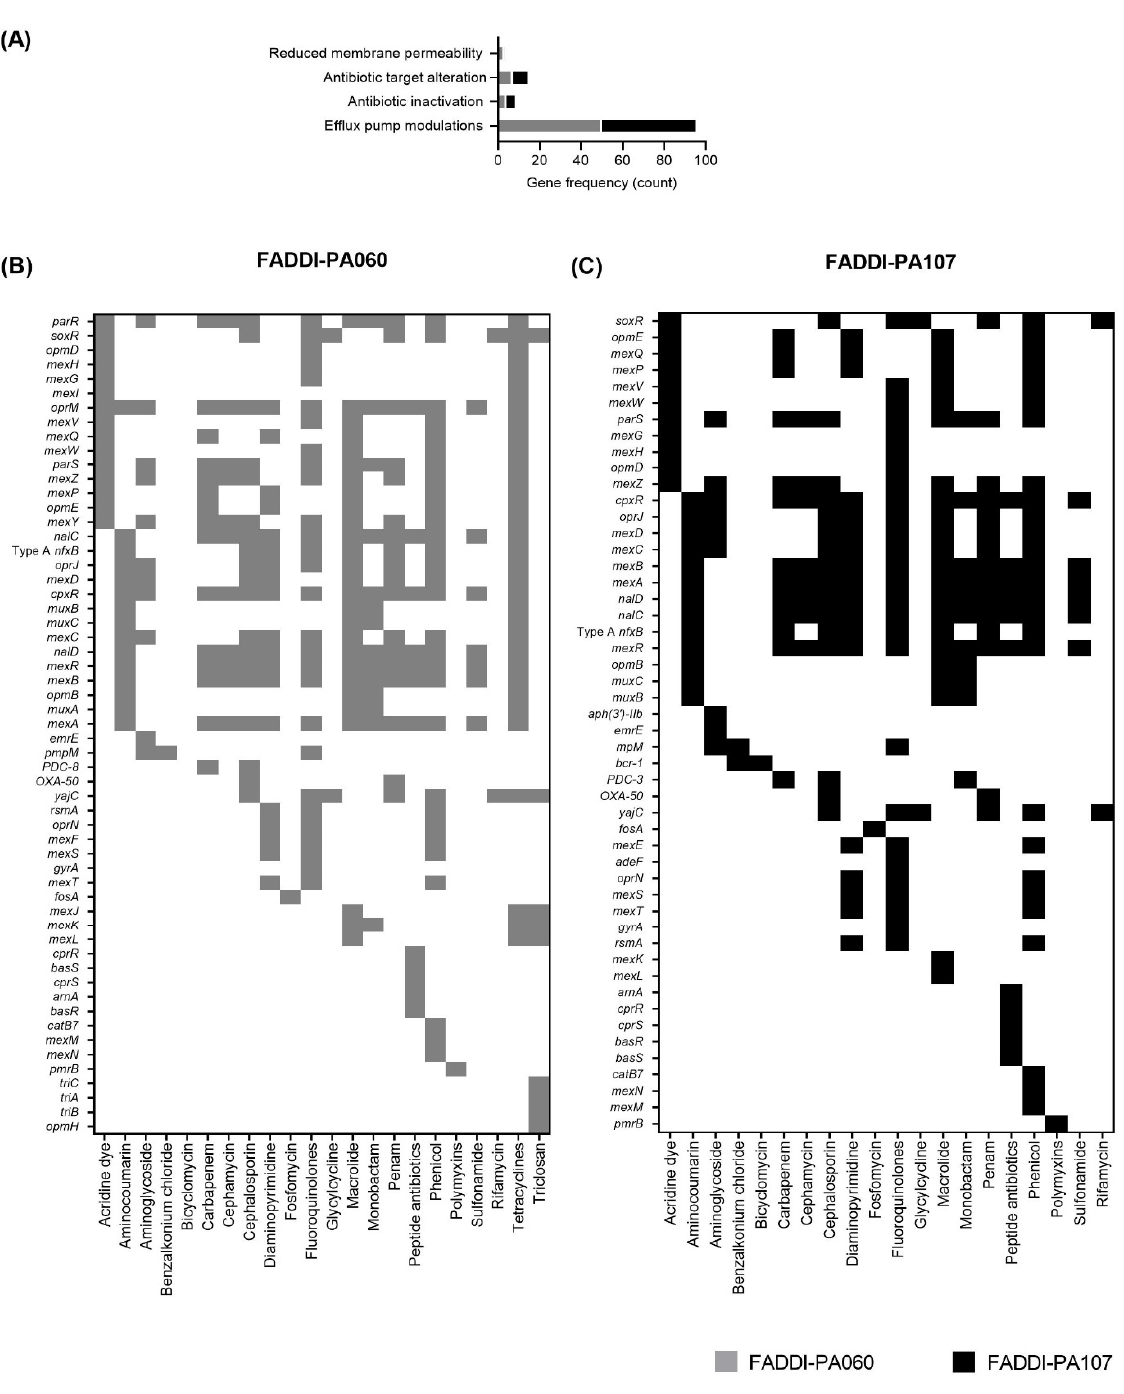
Figure 1. Genome-based antimicrobial resistance predictions for FADDI-PA060 and FADDI-PA107. Frequency of known antimicrobial resistance conferring functional products in FADDI-PA060 and FADDI-PA107 ( A ). Predicted antimicrobial resistance profiles of FADDI-PA060 ( B ) and FADDI-PA107 ( C ). The presence of a gene conferring resistance to a specific antibiotic class is marked by a shaded